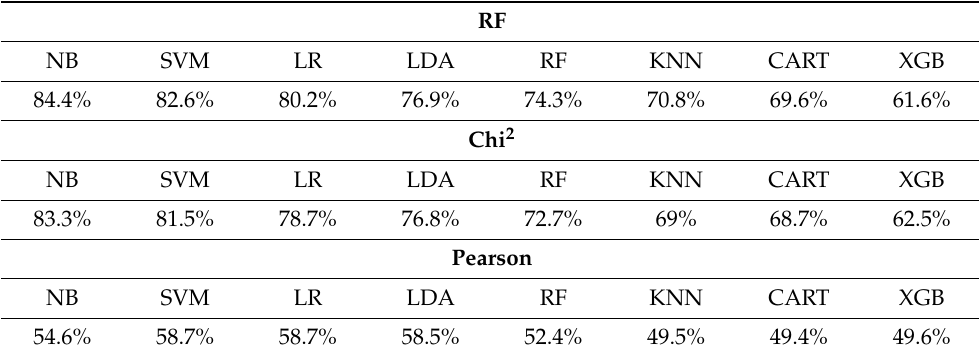
Table 4. Analysis of accuracy for different feature importance methods with ML